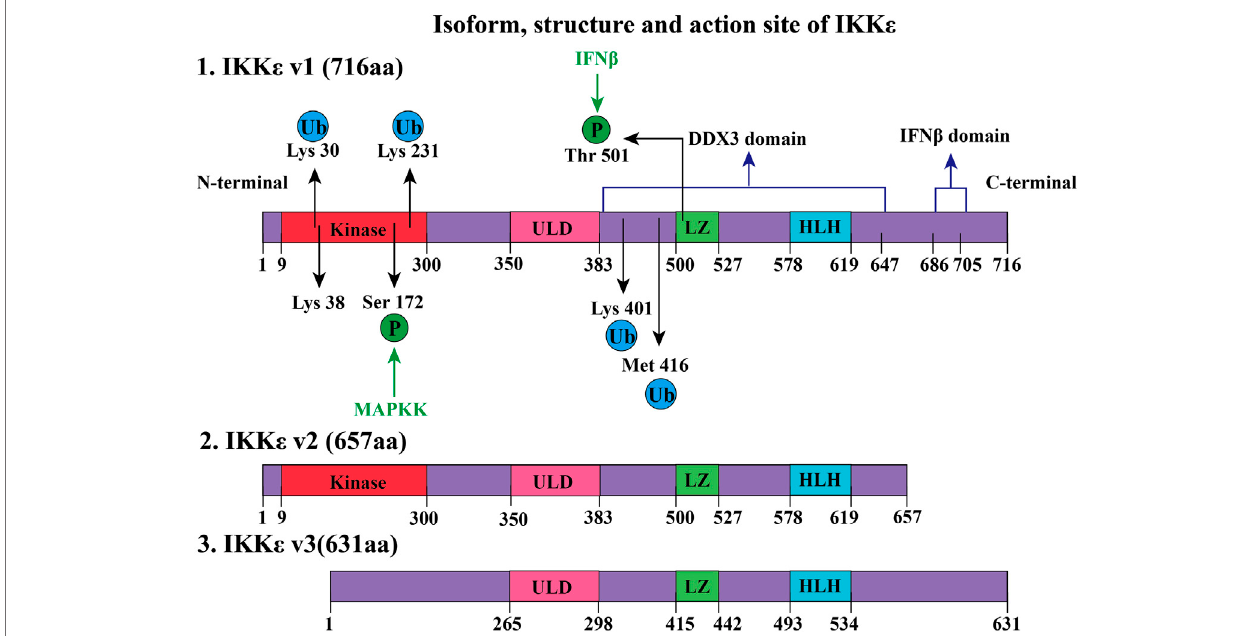
FIGURE1 | Isoform, structure, and active site ofIKK ε . IKK ε exists in three forms, namely,IKK ε v1, IKK ε v2, and IKK ε v3. IKK ε v1is afull-length protein and has 716 amino acids (aa). IKK ε v1 contains several regions: 1) a kinase domain in its N-terminal region, is composed of amino acids 9 – 300 and is a key site of ATP binding. 2) Amino acids at positions 350 – 383 constitute the ULD. 2) LZ consists of amino acids at positions 500 – 527. Phosphorylation of Thr501 at LZ can phosphorylate signal transducer and activator of transcription 1 (STAT1). This process requires participation through K48-linked polyubiquitination. 3) 578 – 619 amino acids form a helix – loop – helix (HLH) structure of IKK ε . 4) Amino acids at positions 383 – 647 form a domain that interacts with human DEAD-box protein 3 (DDX3) to induce Ser172 autophosphorylation of IKK ε . 5) C-terminus amino acid of IKK at positions 686 – 705 constitutes a domain that is closely associated with IFN β promoter activation. K63- linked polyubiquitination occurs by phosphorylation of IKK ε Lys30, Lys401, and Met416. Ubiquitinated IKK ε recruits downstream members of the NF- κ B pathway. Lysine ubiquitination (K63-linked polyubiquitination) at positions 30 and 401 is involved in the development of tumors. SUMOylation of lysine at 231 activates the NF- κ B pathway to prevent apoptosis due to DNA damage. Compared with IKK ε v1, IKK ε v2 lacked 59 amino acids after position 64, but it still retains kinase activity. However, IKK ε v3 lost amino acids from positions 1 – 85, thus losing kinase